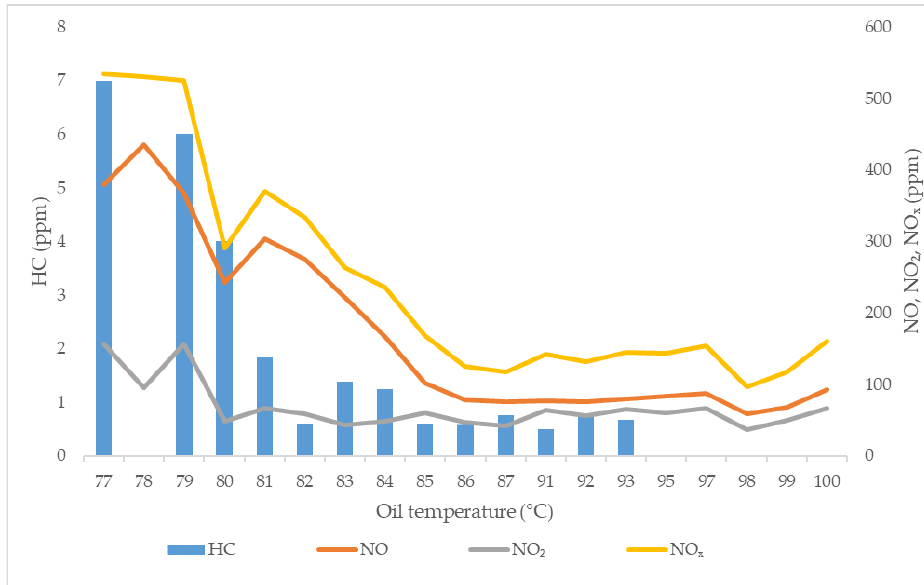
Figure 5. Changes in HC, NO, NO 2 , and NO x concentrations in relation to engine temperature.